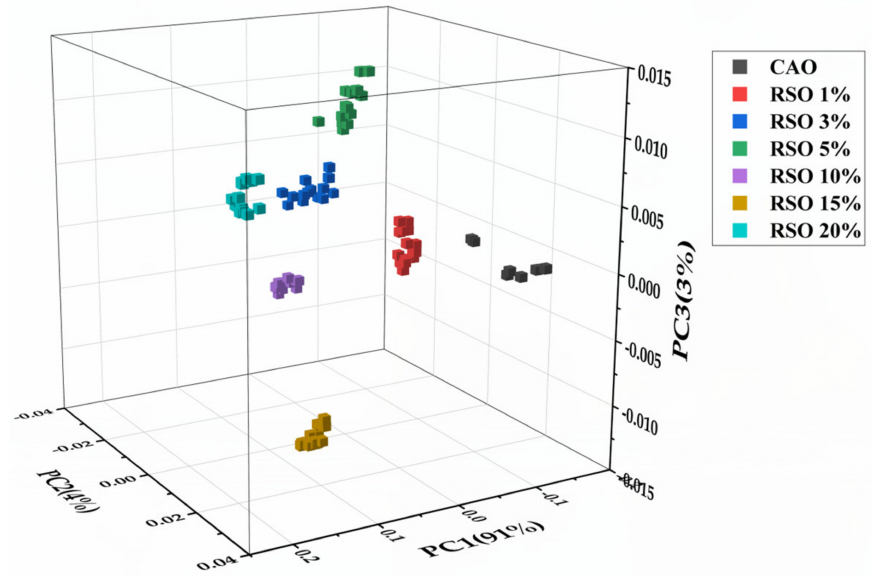
Figure 5. Three-dimensional score plot of CAO and CAO / RSO admixtures from PCA analysis of FTIR spectra in the wavenumber region 1800–650 cm − 1 . CAO, camellia oil; RSO, rapeseed